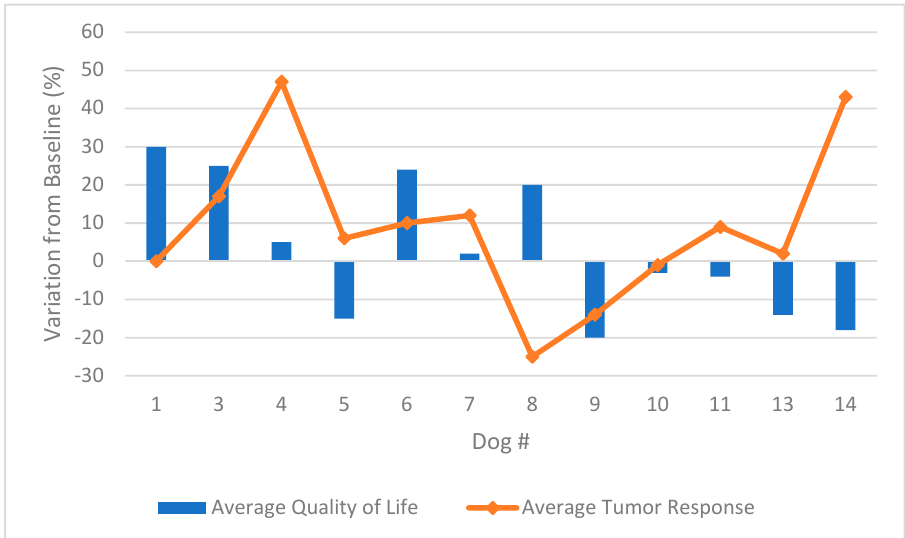
Figure 3. Combination chart of the average change from baseline QL scores and tumor response scores during intratumoral poly-ICLC therapy in 12 patients.